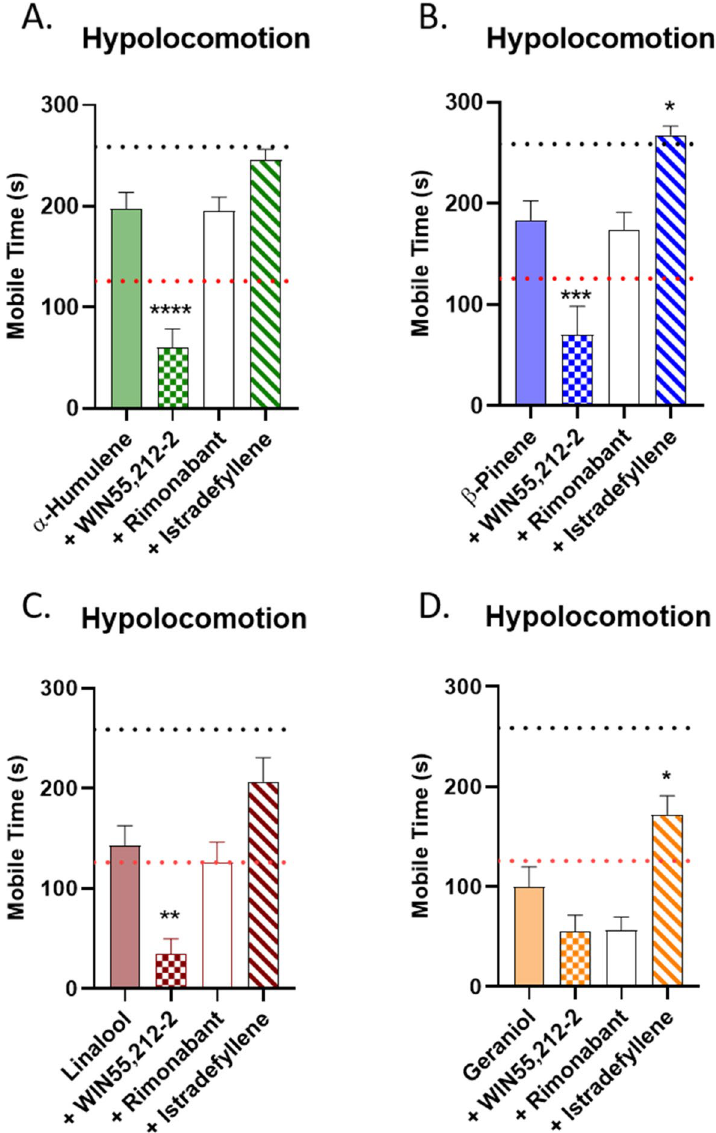
Figure 5. Terpene Induced Hypolocomotion is Partially Mediated by A2a and is Additive with Cannabinoid. Mice were injected with 200 mg/kg terpene alone, combined with 5.6 mg/kg WIN55,212-2, or after pretreatment with 10 mg/kg rimonabant or 10 mg/kg istradefyllene, i.p. . After 10 min mice were then placed back into the open field box for a 5 min test. ( A ) α-Humulene, ( B ) β-Pinene, ( C ) Linalool and ( D ) Geraniol. Data represents the mean ± SEM of mobile time seconds (n = 10–20/group). Statistics analyzed via one-way ANOVA, Dunnett’s post hoc; * p < 0.05, ** p < 0.01, *** p < 0.001, **** p < 0.0001 compared to terpene alone. The black dotted line denotes vehicle levels of mobile time for reference, while the red dotted line represents the effect of 5.6 mg/kg WIN55,212-2 alone, both taken from Fig.